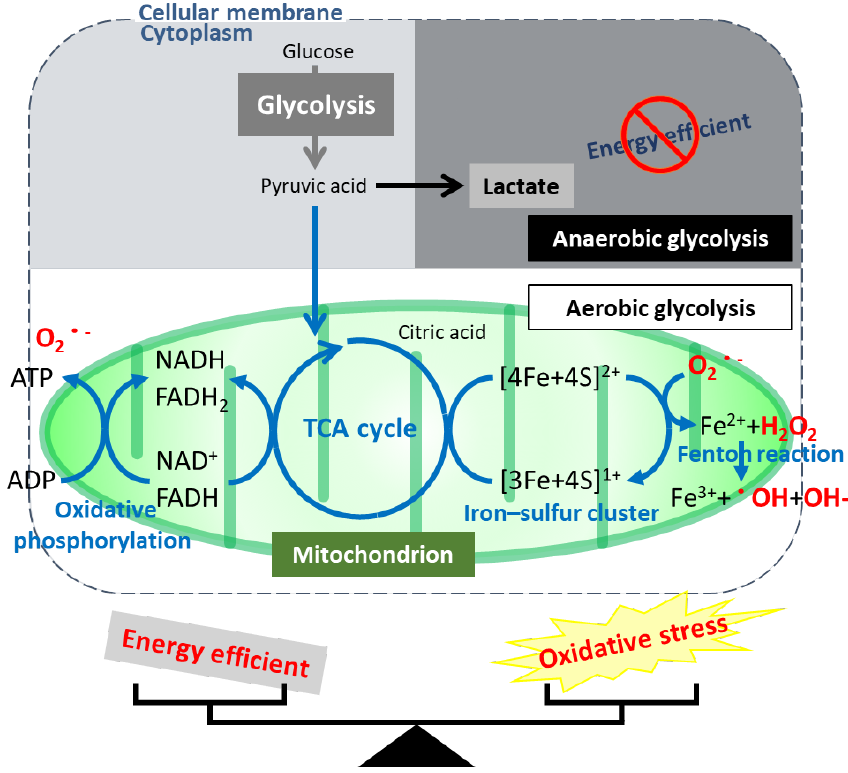
Figure 1. Mitochondrion is a “double - edged sword”. The balance between the state of energy efficient and oxidative stress in a mitochondrion.